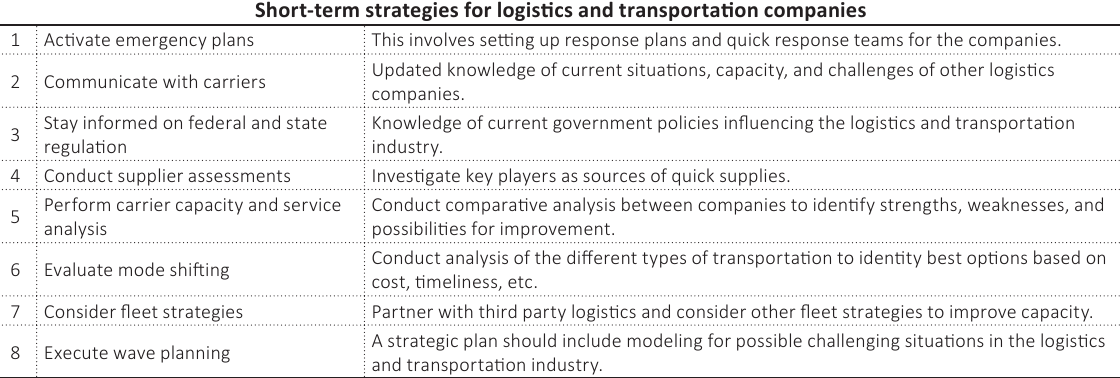
Table 2. Short-term strategies for logistics and transportation companies to curb the impact of the COVID-19